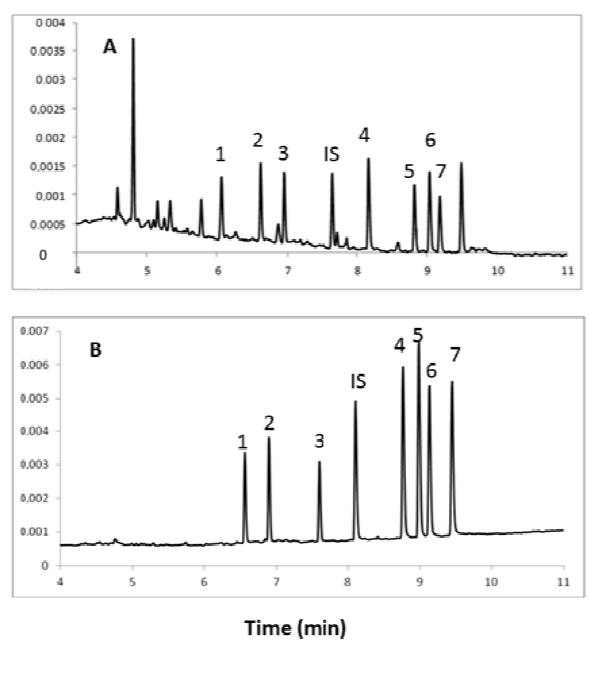
Figure 2. Electropherograms obtained during the electrophoretic separation of the urine sample containing 8 steroid hormones analyzed at λ = 200 nm ( A ) and 254 nm ( B ). Other conditions the same as in Figure 1. Analytes: 1—cortisone, 2—cortisol,